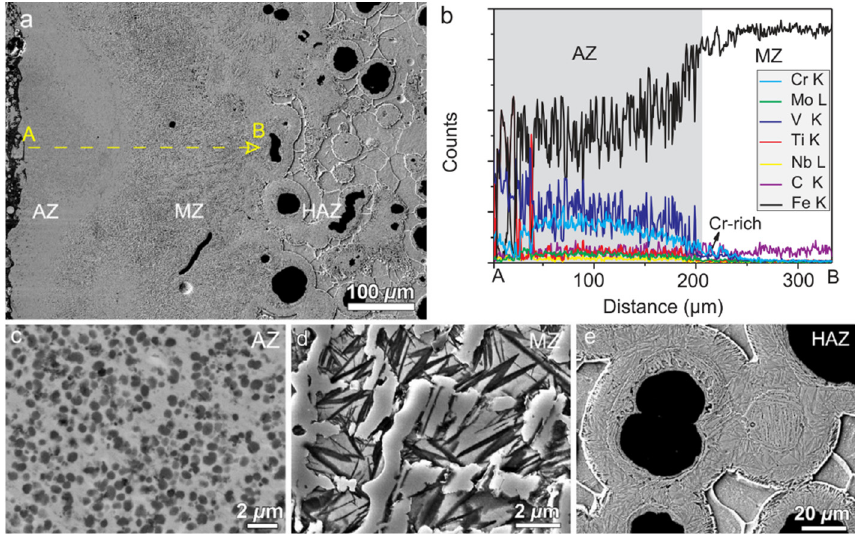
Figure 16. ( a ) SEM images showing the cross-section of the HVHSS graded coating and ( b ) linear EDS scan along the line A–B marked in ( a ); Close view of the microstructure of the alloying zone (AZ) ( c ), melting zone (MZ) ( d ) and heated affected zone (HAZ) ( e ), respectively [64].